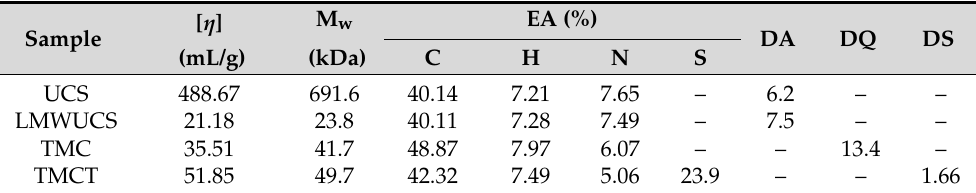
Table 1. Microanalytical properties of UCS